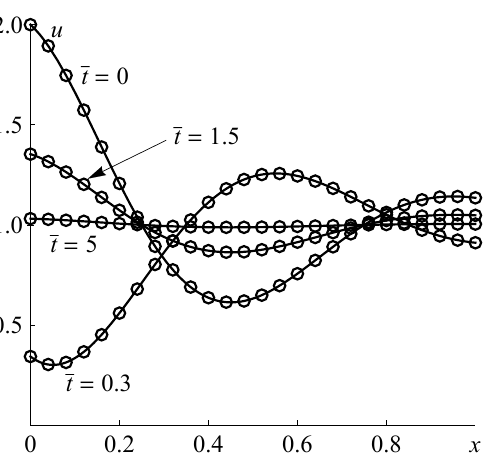
Figure 7. The exact solutions (solid lines) and the numerical solutions obtained by the combination of the method of lines and the second-order implicit Runge–Kutta method (circles) of test problem 4 for a = 1, k = τ = 0.5, and N = 100 at different times ¯ t = t / τ .